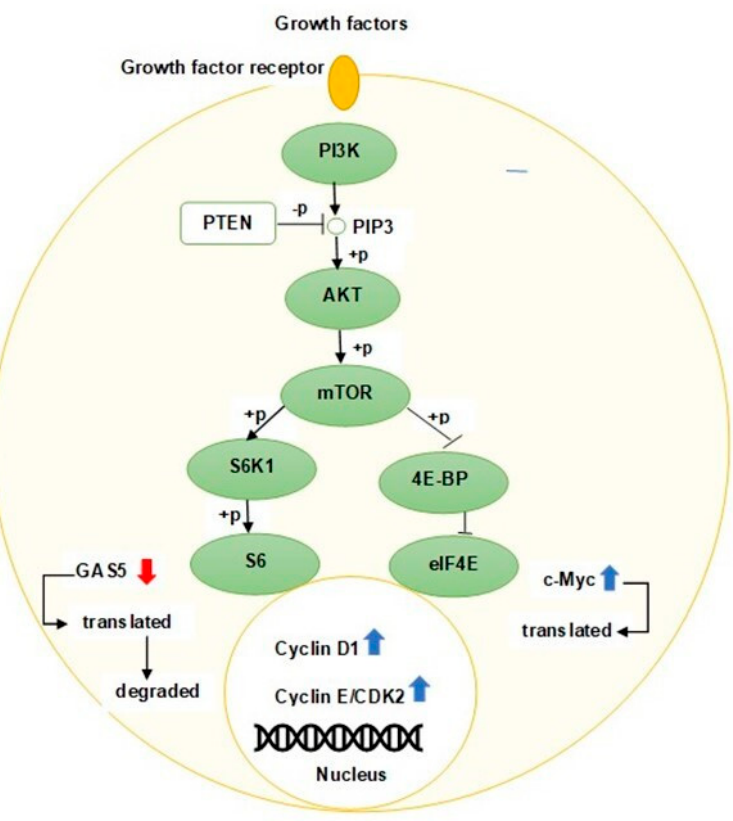
Figure 3. Schematic representation of proliferating cell with activated PI3K/AKT/mTOR pathway . The ribosomal S6 protein is phosphorylated (+p) when the PI3K/AKT/mTOR pathway is activated, resulting in translation and degradation of GAS5 by the NMD pathway. Downregulation of GAS5 causes an increase in c-Myc protein, thereby facilitating cell cycle progression via inducing activation of cyclin-CDK complexes. PTEN, a tumor suppressor protein, blocks the PI3K/AKT/mTOR signaling pathway by dephosphorylating ( − p) PIP3.